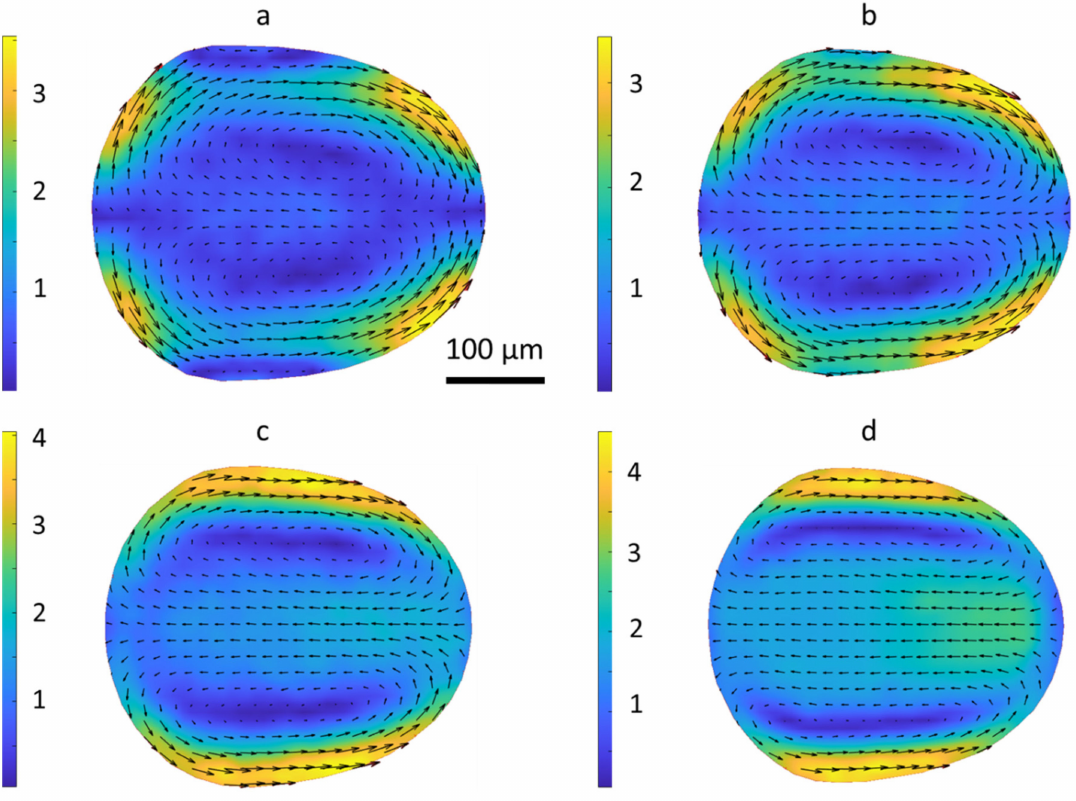
Figure 9. Flow patterns within the drop laden with Triton X-100, at a concentration of 0.3 mM ~ 0.3 CMC. Drop length L = 392 µ m, total follow rate Q = 32 µ L/min, drop velocity V d = 9.6 mm/s, ( a )—middle plane, ( b )—40 µ m from the middle plane, ( c )—60 µ m, ( d )—80 µ